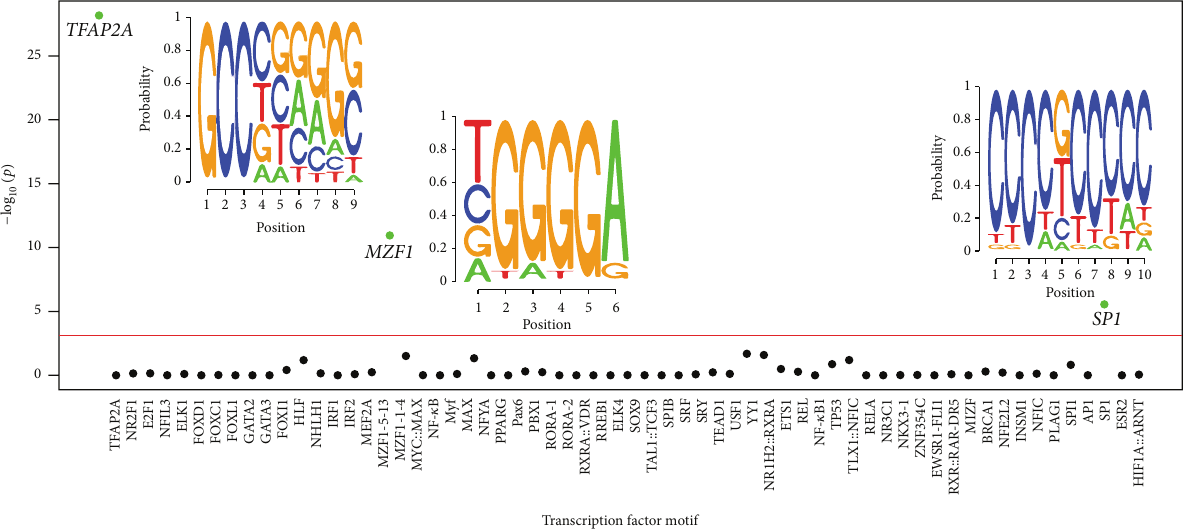
Figure3:EnrichmentanalysisofJASPARtranscriptionfactorbindingsites(TFBSs).PutativeTFBSswereevaluatedinboththeWNTpathway gene set and across the entire genome for enrichment using the hypergeometric distribution with Bonferroni correction for multiple testing (the red line indicates 𝑃 = 0.001 ). TFAP2A , MZF1 , and SP1 were significantly enriched across WNT pathway genes ( 𝑃 < 6.83 × 10 − 29 , 1.34 × 10 −11 , and 3.01 × 10 −6 , resp.). TFBS sequence motifs are illustrated with the height of each base indicative of the probability of the presence of the corresponding base at the designated